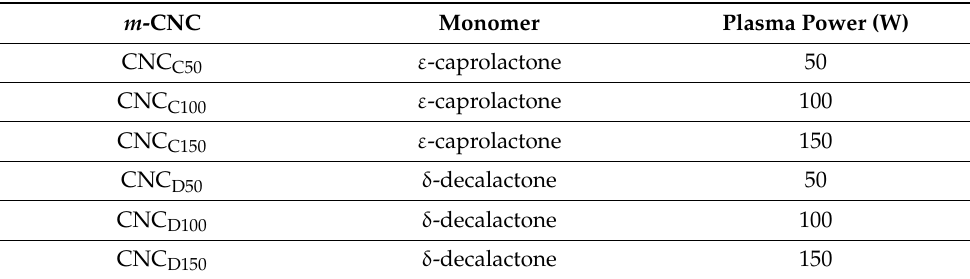
Table 1. Monomers and plasma powers of plasma used in the surface modification by plasma- induced polymerization.